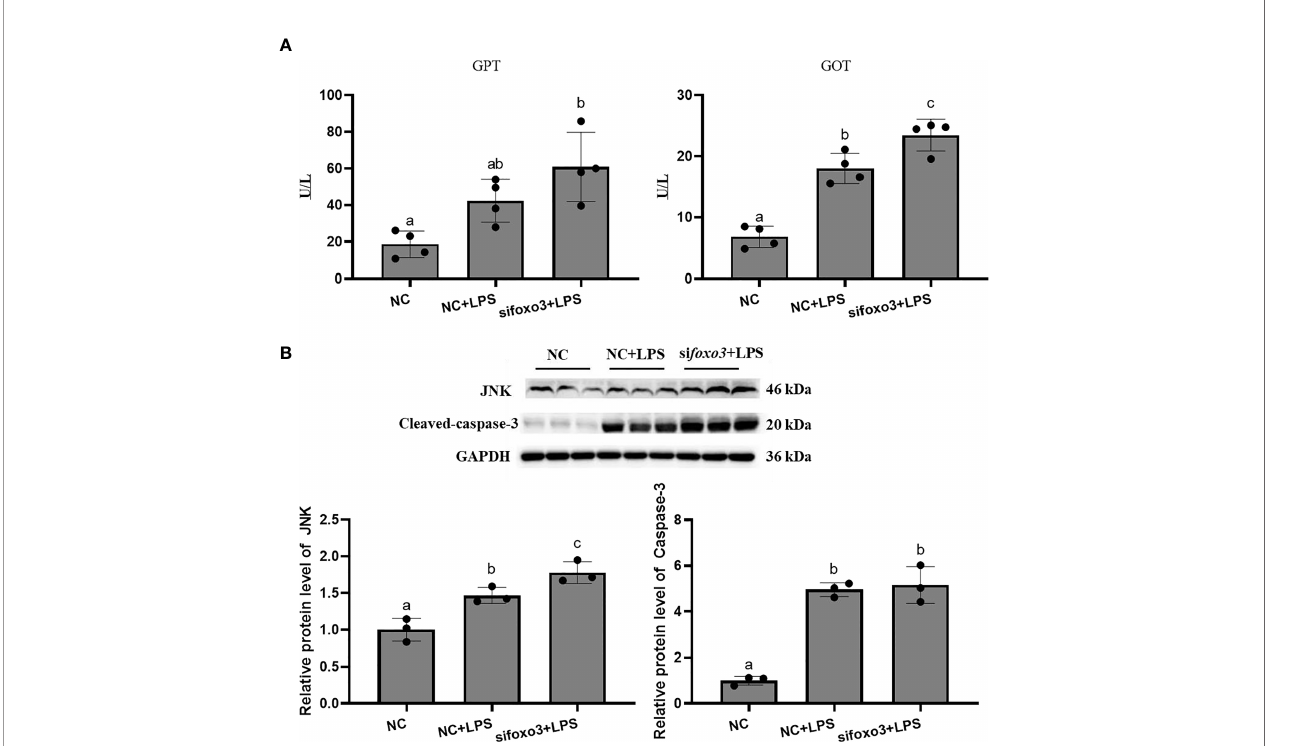
FIGURE 7 | (A) The levels of glutamate pyruvate transaminase (GPT) and glutamate oxaloacetate transaminase (GOT) in serum. Values are represented as the mean ± standard deviation (n = 4). Values with different letters mean signi fi cantly difference ( P < 0.05). (B) Protein levels in turbot liver. The relative protein abundances of JNK and cleaved-caspase-3 in turbot liver were measured by western blot and expressed as relative expression values to those in NC group. Values are represented as the mean ± standard deviation (n = 3). Values with different letters mean signi fi cantly difference ( P < 0.05).